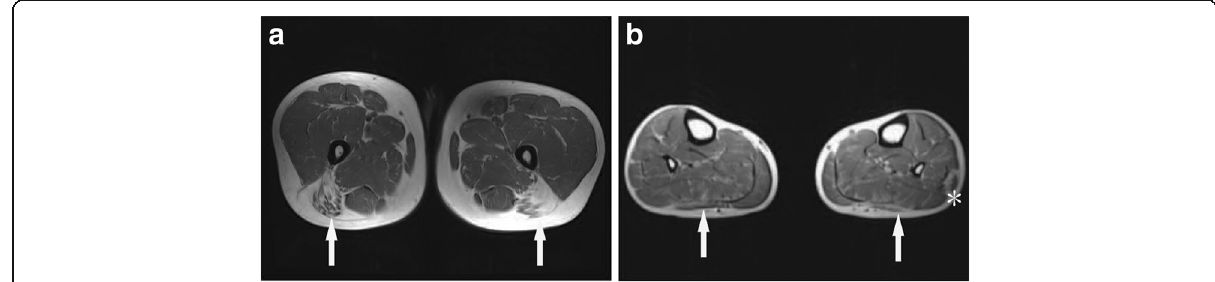
Fig. 1 Muscle MRI comprising T1-weighted images of the thigh and lower leg from patient 2. a . Transverse cuts from the mid-thigh muscles showed mild increase in signal intensity within the femoris long head (arrows); b , Transverse cuts from the lower leg showed mild increase in signal intensity within the peroneus longus (arrows) and there was atrophy of gastrocnemius lateral heads